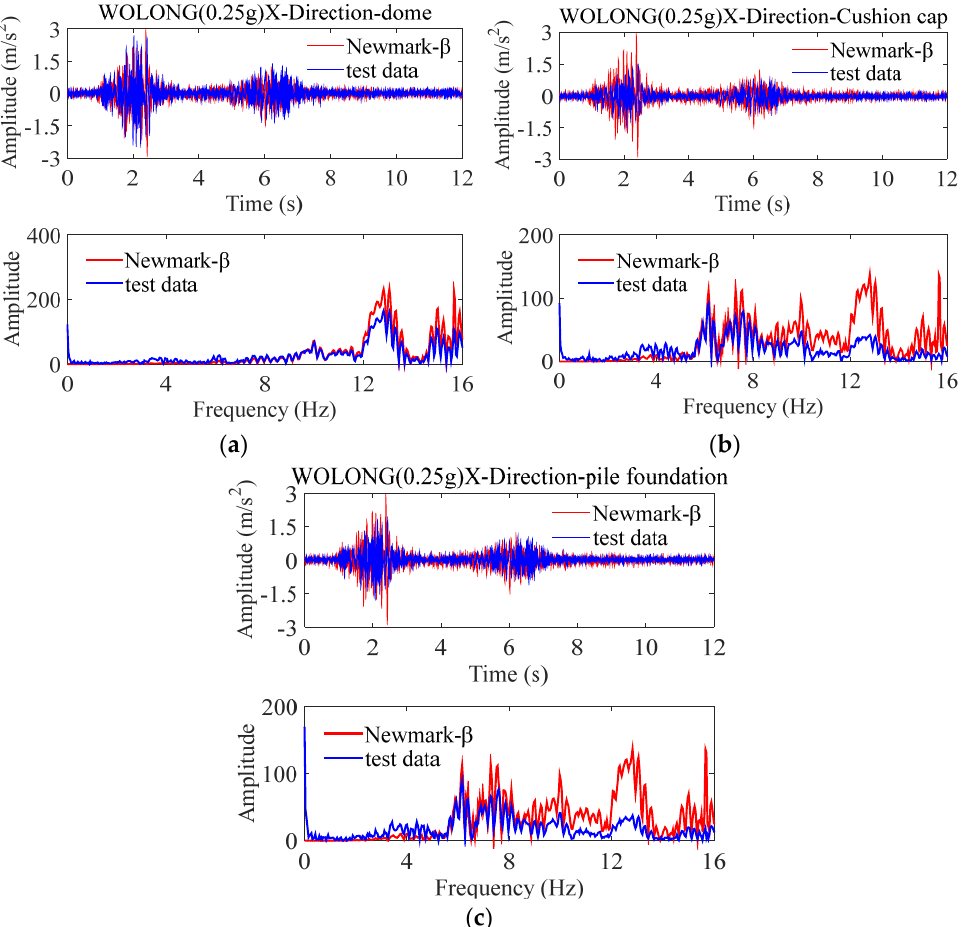
Figure 15. Comparison of shaking table test data and theoretical solutions under the Wolong wave: ( a ) dome acceleration time history and spectrum comparison; ( b ) cushion cap acceleration time history and spectrum comparison; ( c ) pile foundation acceleration time history and spectrum comparison.